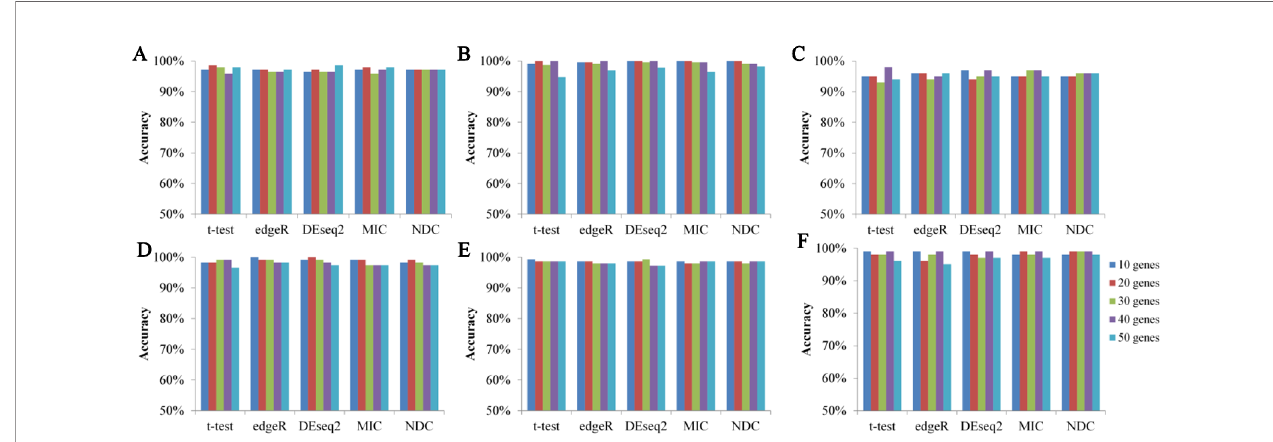
FIGURE 6 | Prediction accuracy of fi ve methods on six datasets based on supported vector classi fi er (SVC). (A) BRCA, (B) KIRC, (C) LIHC, (D) LUAD, (E) LUNG, (F)